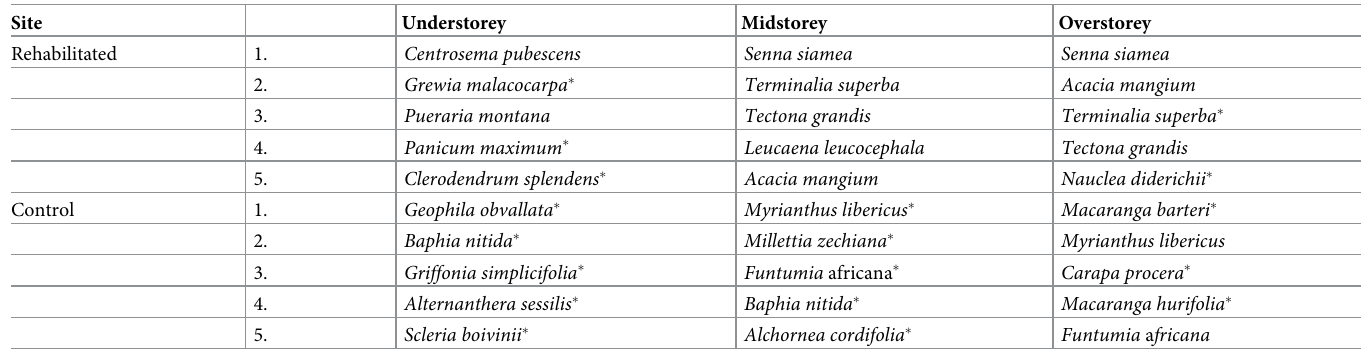
Table 2. Top five most common species in the three strata of the two site types.